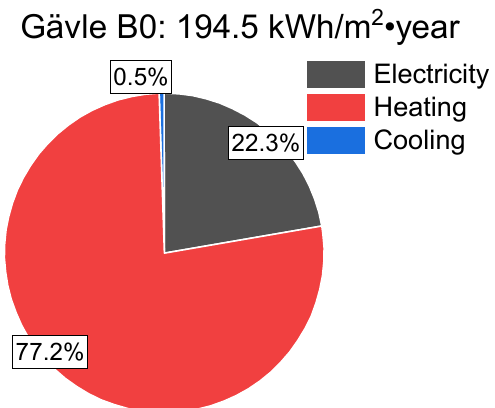
Figure 8. Breakdown of building’s annual energy usage for B0.